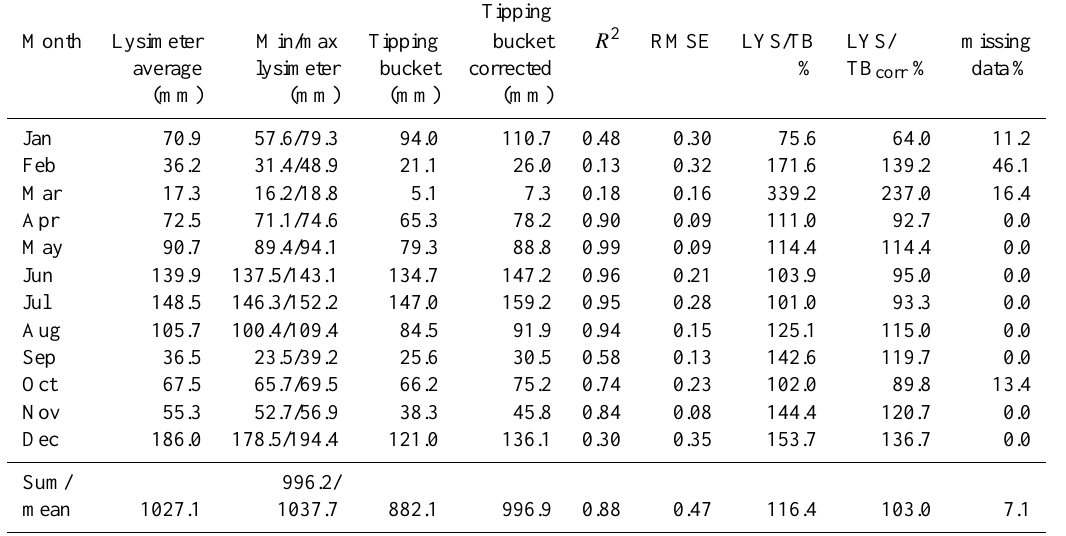
Table 2. Monthly precipitation sums for lysimeter, tipping bucket, and corrected tipping bucket data, and a comparison between the hourly precipitation values of lysimeter and uncorrected TB in terms of coefficient of determination ( R 2 ), root mean square error, and other statistics at the Rollesbroich study site for 2012. “Missing data %” refers to the percentage of hourly precipitation data not available for comparison.